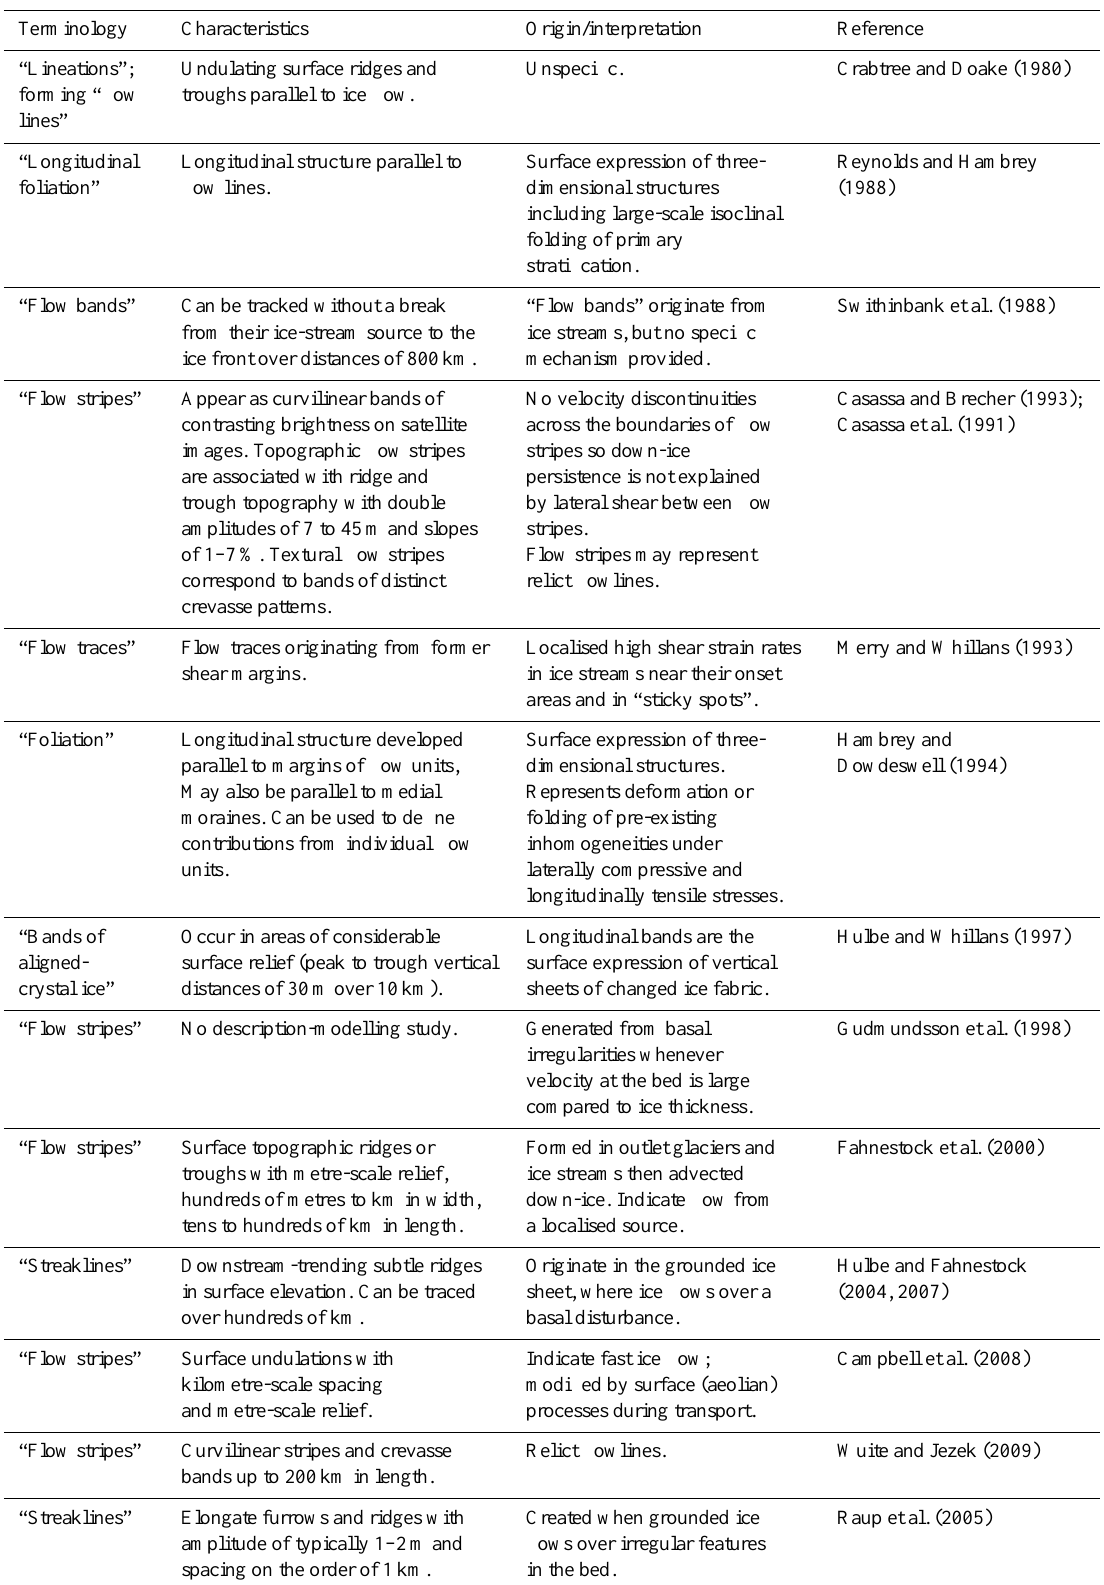
Table 1. Previously reported terminology and characteristics of longitudinal surface structures on Antarctic glaciers and ice